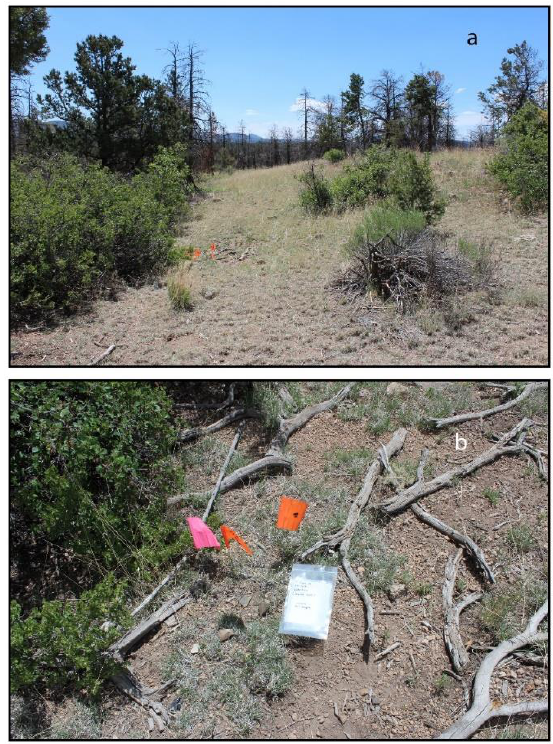
Figure A2. Context photos of ( a ) one of the ceramic collection locations in the midden area that was unburned in 2012 CE but would have burned historically between 1696 and 1893 CE (NM samples) and ( b ) the unburned fuels around sample NM-35 that was reset in 2012 indicating that it could not have burned in 2012 in this context and thus has moved from its 2012 location. Orange and pink flags indicate the location of ceramic samples. (Photos by C. Roos.)